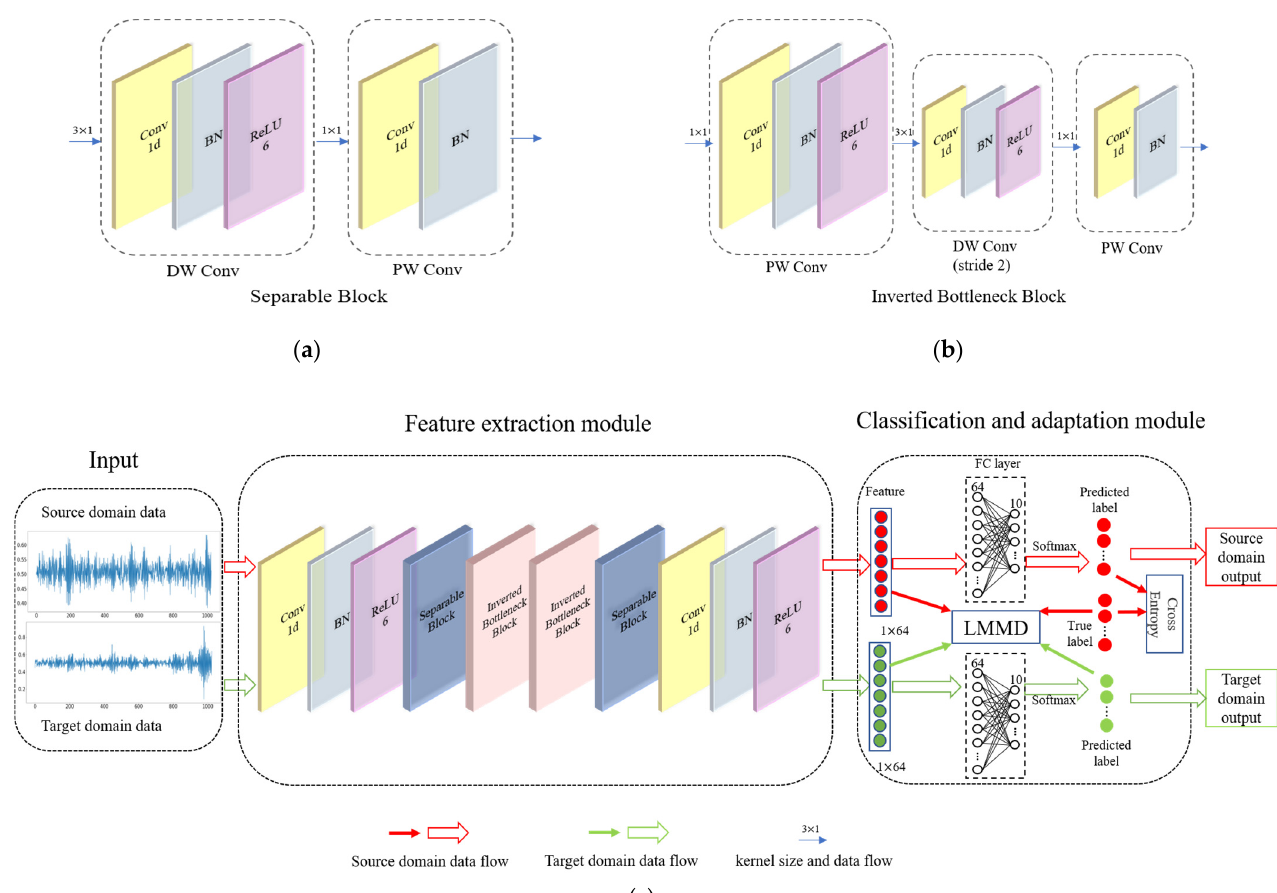
Figure 2. Schematic diagram of the proposed 1D-LDSAN framework. ( a ) is the structure diagram of the separable block shown in ( c ). ( b ) presents the structure diagram of the inverted bottleneck block shown in ( c ). ( c ) displays the overall framework.